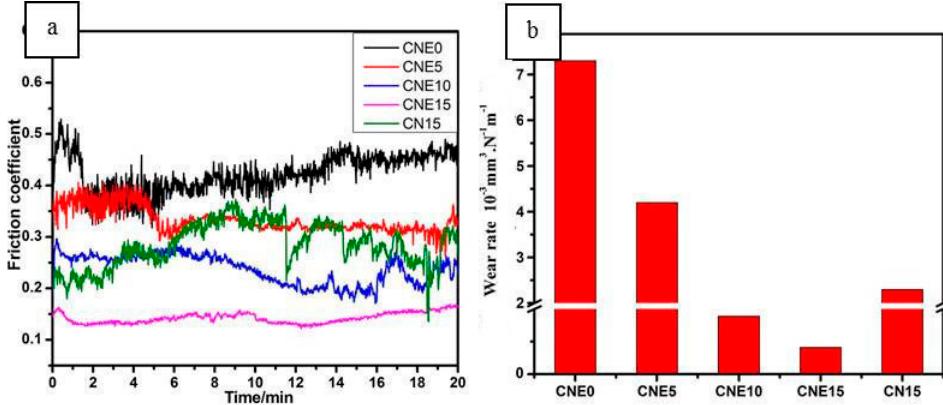
Figure 4. Friction coefficient ( a ) and wear rate ( b ) of Cu/Ni/NbSe 2 composites.